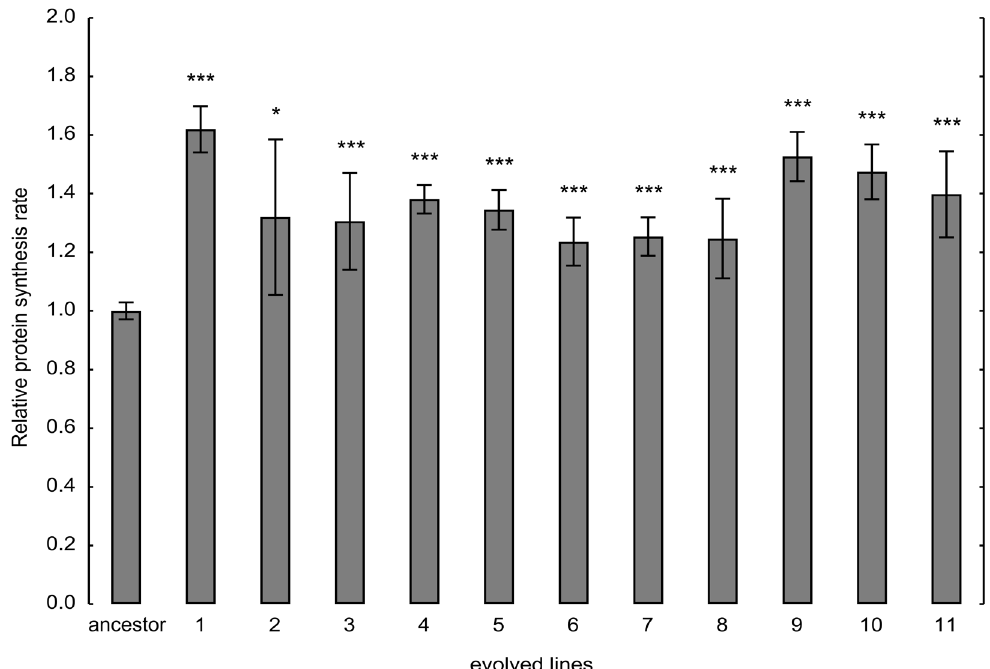
Fig 3. Evolution of protein synthesis rate. Amino acid incorporation rate was measured by protein pulse labeling with [ 14 C(U)]-L-Amino Acid mixture. The bars indicate mean ± 95% confidence interval. Two-sample t test was used to assess difference in protein synthesis rate between ancestor and evolved lines. * / ** / *** indicates p -value < 0.05/0.01/0.001.